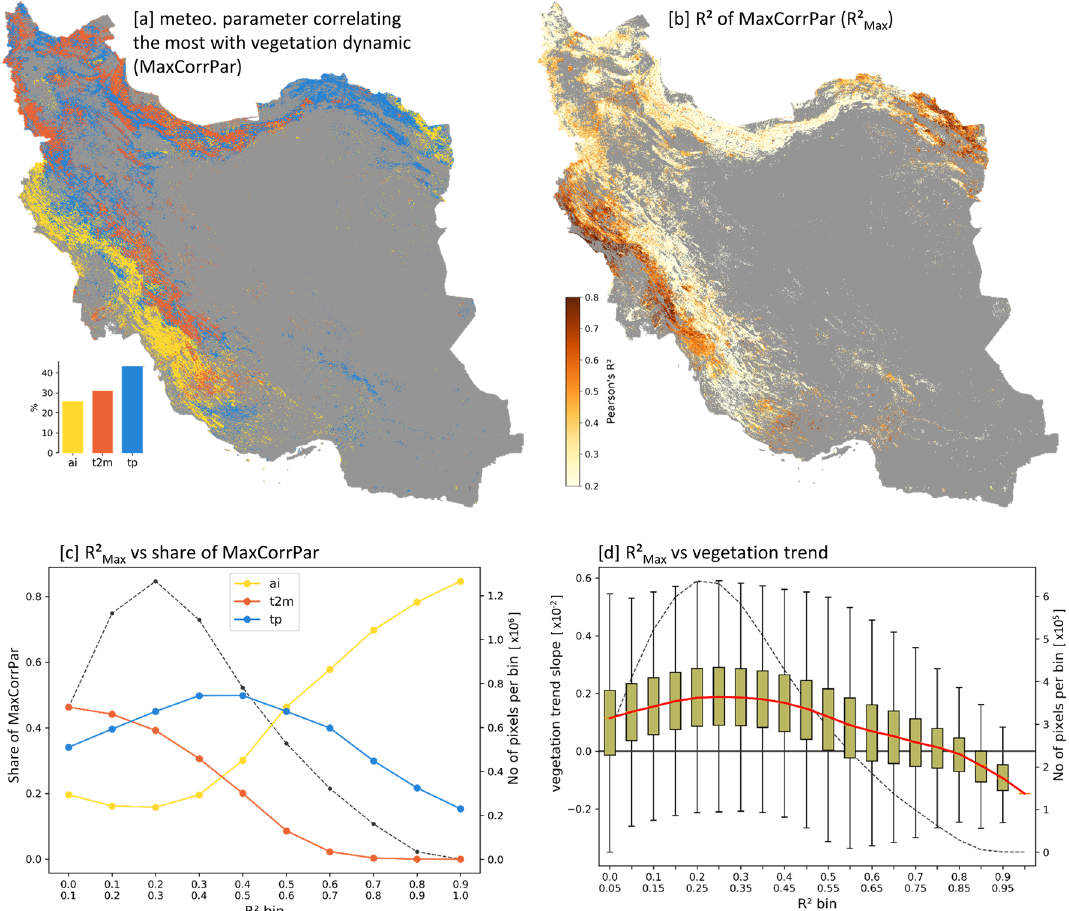
Figure 7. Natural vegetation growth dynamics versus meteorological conditions. Pearson correlation of annual vegetation growth ( NDVI MEAN ∗ ) and annual aggregates of meteorological parameters. ( a ): The map depicts the meteorological parameter that correlates the most (highest R 2 ) with the vegetation growth dynamics at each pixel. ( b ): Pearson’s R 2 value of highest correlating meteorological factor ( R 2 Max ). Note: individual correlations for each meteorological parameter can be found in Figure S15. ( c ): Proportion of highest correlating meteorological factor per R 2 bin (black dotted line: number of pixels per bin). ( d ): Vegetation growth trend (trend slope of annual vegetation growth time series) versus R 2 of highest correlating meteorological factor ( R 2 Max ). (Per bin a boxplot is shown. Red line: median of the vegetation growth trends per bin. Black dotted line: number of pixels per bin). Maps were created using Python 3.9 (https:// www. python. including vegetated and non-vegetated pixels. The highest correlation for all three vegetation datasets can be observed for the precipitation ( tp ) as primary water input (Fig. 6b). Inspecting individual years (Fig. 6a) reveals that the driest years of the analyzed period (2001 and 2008) result in lowest NDVI MEAN ∗ and the wettest year of 2019 in highest NDVI MEAN ∗ . In case of the total water storage ( TWS ) the vegetation growth is negatively correlated, showing a vegetation growth increase despite decreasing TWS , which suggests unsustainable use of groundwater resources to irrigate vegetation. Natural vegetation growth dynamics compared to meteorological water availability and elevation. Natural vegetation is analyzed in relation to meteorological conditions, by correlating the annual vegetation growth ( NDVI MEAN ∗ ) with the annual aggregates of tp , ai , and t 2 m as three parameters mainly controlling the local